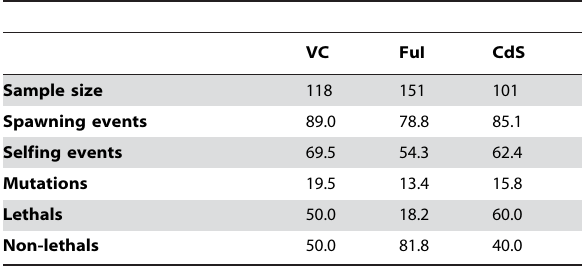
Table 1. Screening of Ciona intestinalis sp. A populations for naturally occurring mutations.